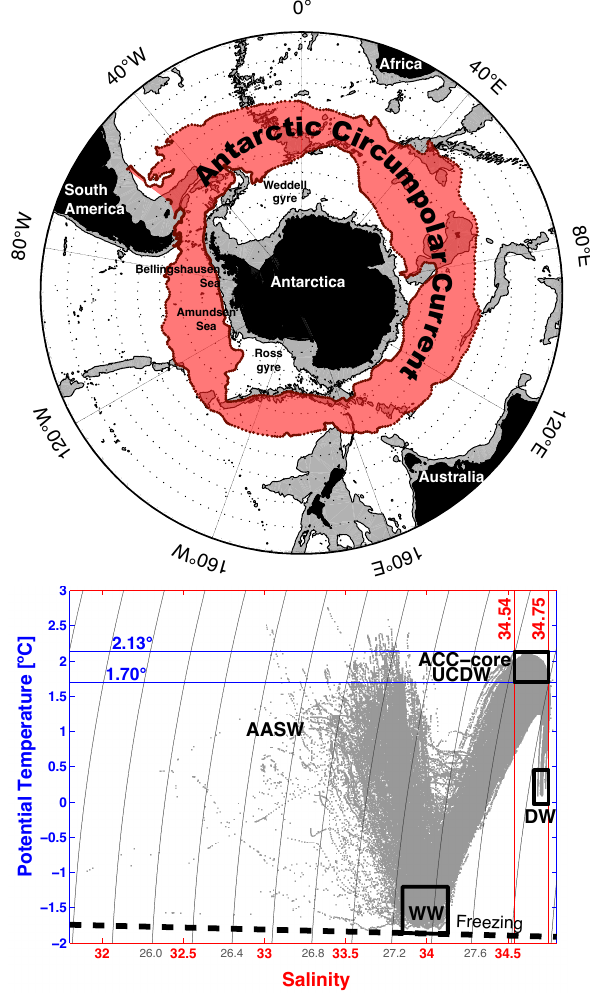
Fig. 2. Location of climatological ACC, transporting warm UCDW. The ACC flows along the slope-shelf break for the entire western Antarctic. Bathymetry shallower than 3km is shaded. The lower panel is showing primary water masses in LTER sampling grid (from MSISV08). UCDW is warmest water in water column, oc- casionally exceeded in temperature by the summer surface layer